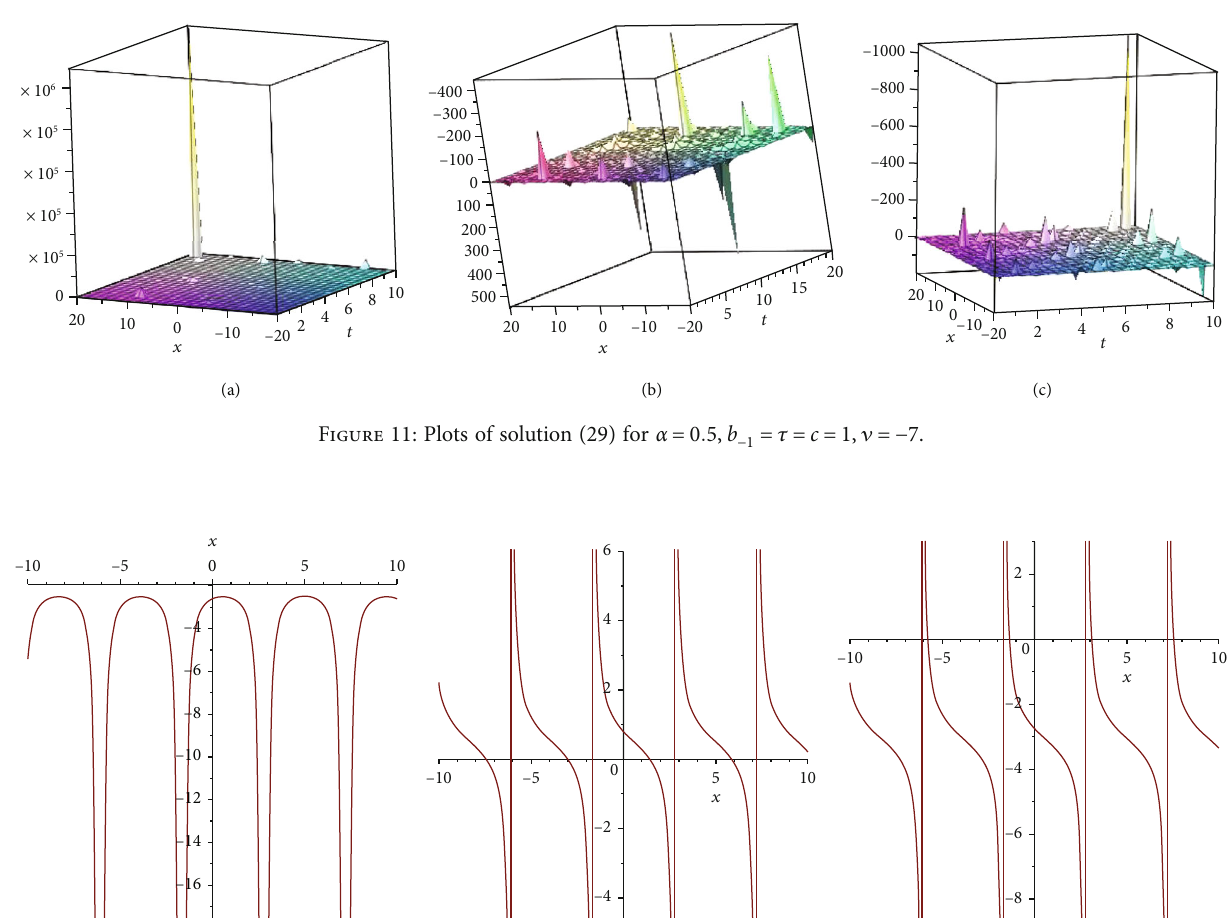
Figure 12: Plots of solution (29) for α = 0 : 5, b